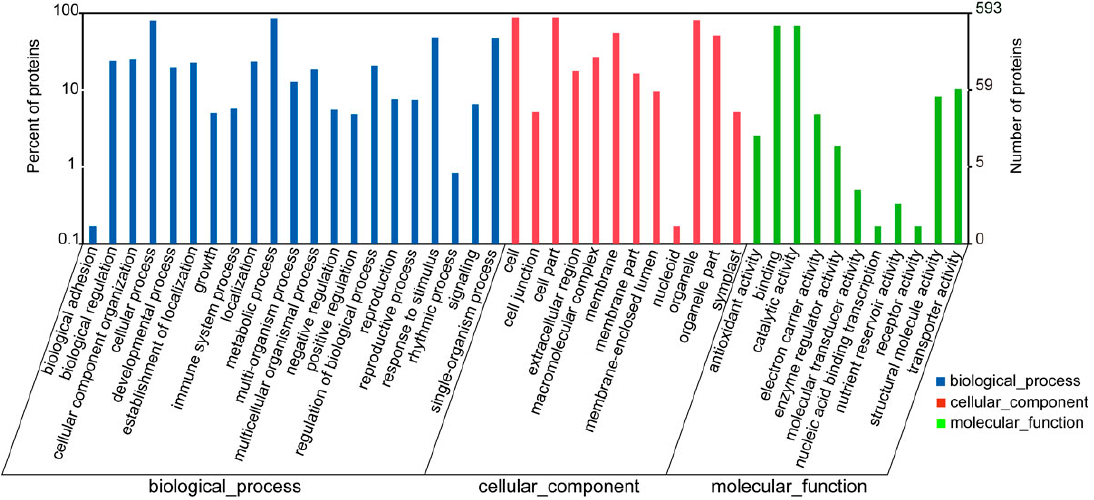
Figure 3. The categorization of proteins is based on gene ontology (GO) annotation. The category number is displayed with biological process, cellular components, and molecular functions. y -axis ( left ) represents percentages of proteins identified, y -axis ( right ) represents the protein number.